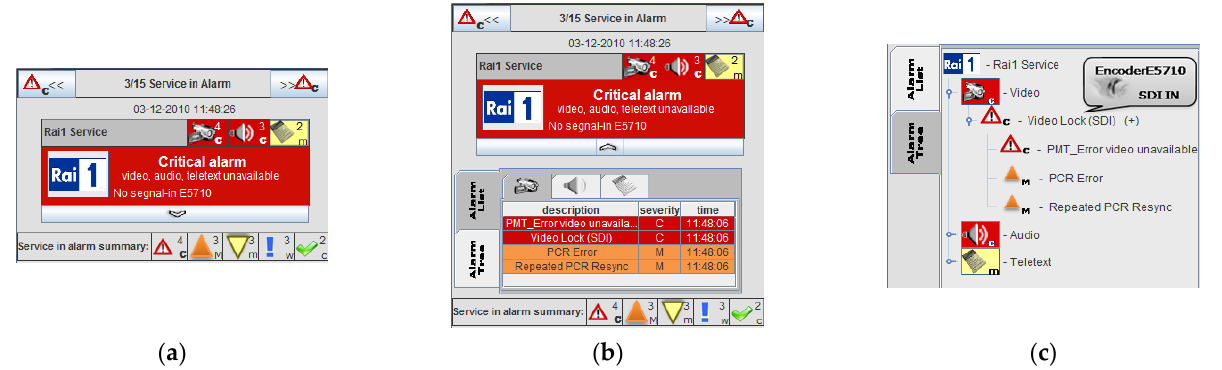
Figure 14. The GLANCE-inspired “Service in alarm” fault notification display: ( a ) A sample glanceable low-LOD overview of an alarmed service providing summary data (number and severity) on its components and their associated alarms on devices, and a service-centric network overview in term of summary of total services in alarm. Operators can access views with higher LOD by clicking on the small arrow at the bottom of the service overview, like in GLANCE+ an in this case this action discloses a tabbed on-demand panel providing details on service alarms either as a list as in ( b ), or as a browsable alarm tree as in ( c ) (clicks on tree items provide an additional LOD on devices in a balloon fashion).